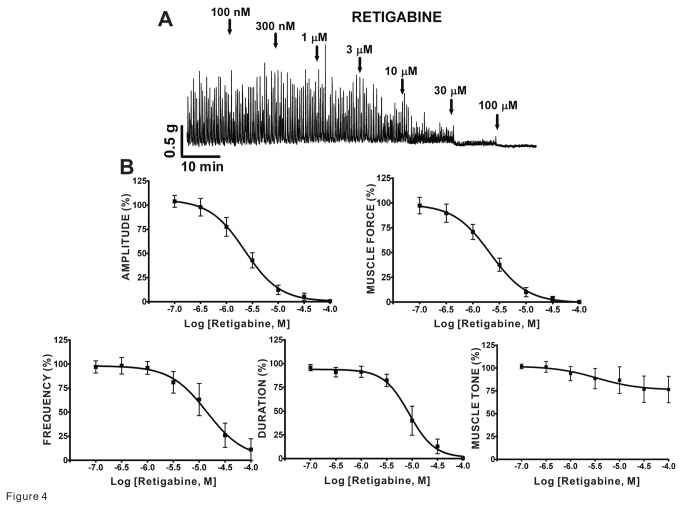
Kv7.2-Kv7.5 channel opener retigabine decreased spontaneous phasic contractions in guinea pig DSM isolated strips.
A) This original DSM tension recording illustrates retigabine inhibitory effects on spontaneous phasic contractions of DSM isolated strips in a concentration-dependent manner. B) Cumulative concentration-response curves for retigabine summarize reduction in DSM spontaneous phasic contraction amplitude, muscle force, frequency, and duration (n=7, N=6); see Table 1 for potency and maximum efficacy values. TTX (1 µM) was present throughout the experiments.